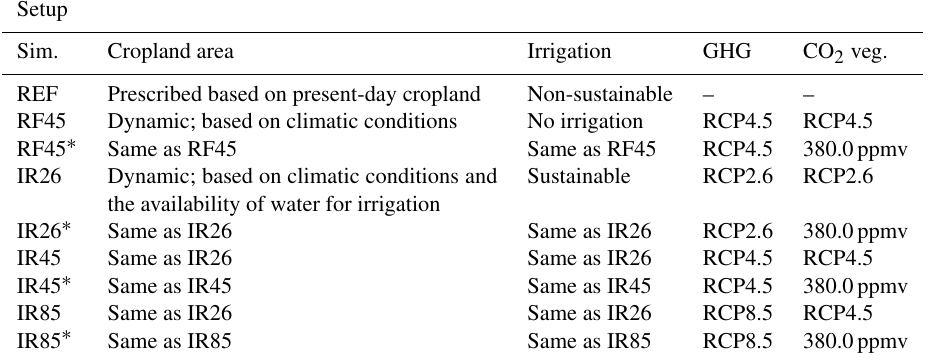
Table 1. Experimental overview. The table provides an overview of the simulations performed in the context of the present study. The upper part shows the most important characteristics of the simulation setup, specifying the crop management scheme, i.e., the expansion and decline of cultivated areas and the irrigation scheme, the representative concentration pathways (RCP) to which the greenhouse gas (GHG) forcing corresponds, and which CO 2 concentration was used in the model’s vegetation scheme. The lower part summarizes the most important results, namely the simulated global extent of cultivated areas and the corresponding supportable population size ( K hum ) in the year